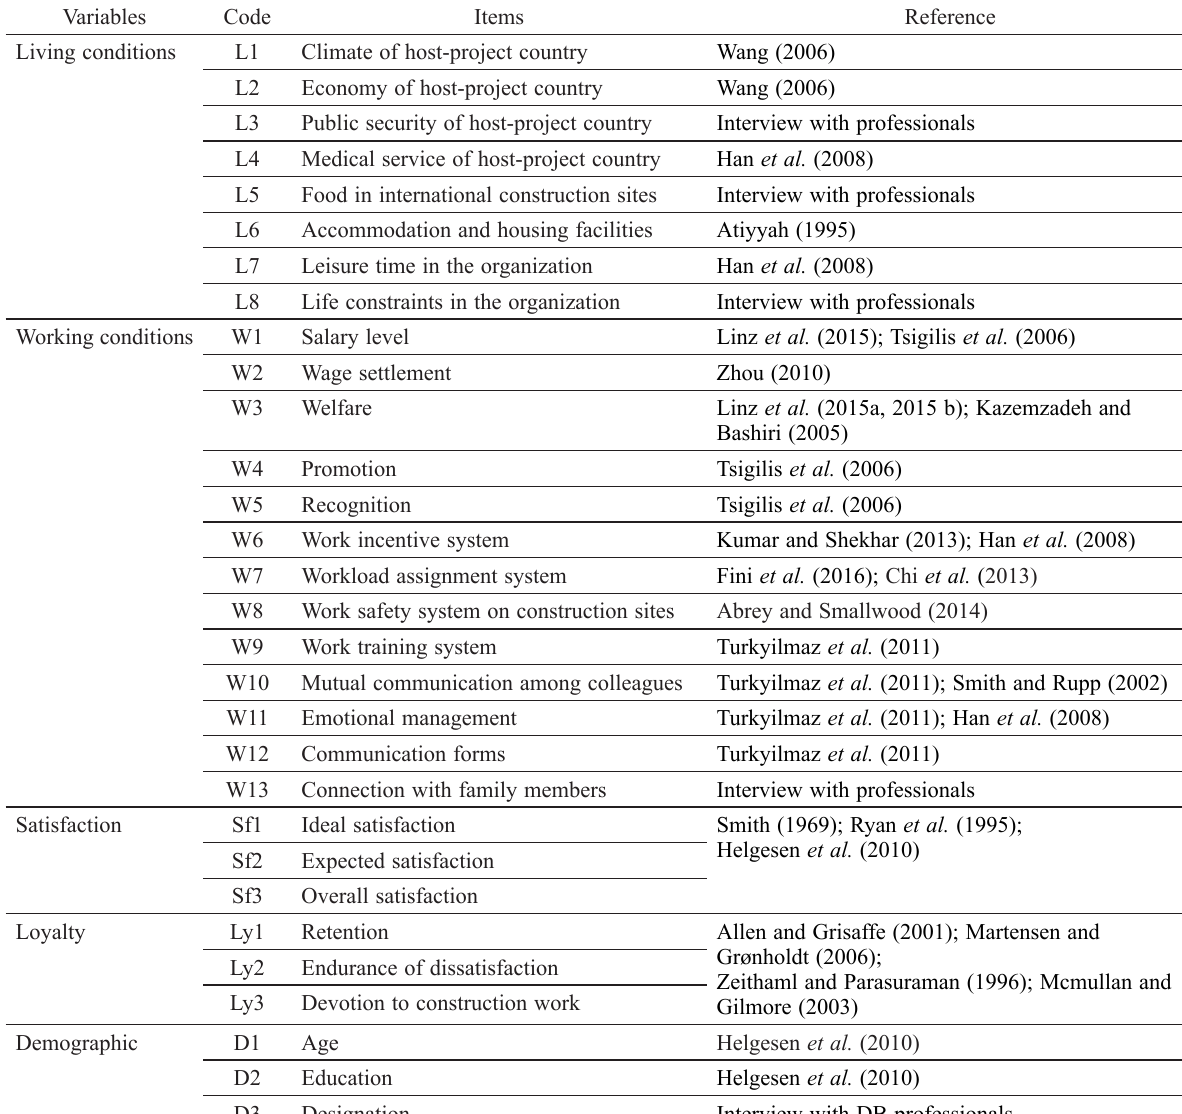
Table 1. Summary of items Variables